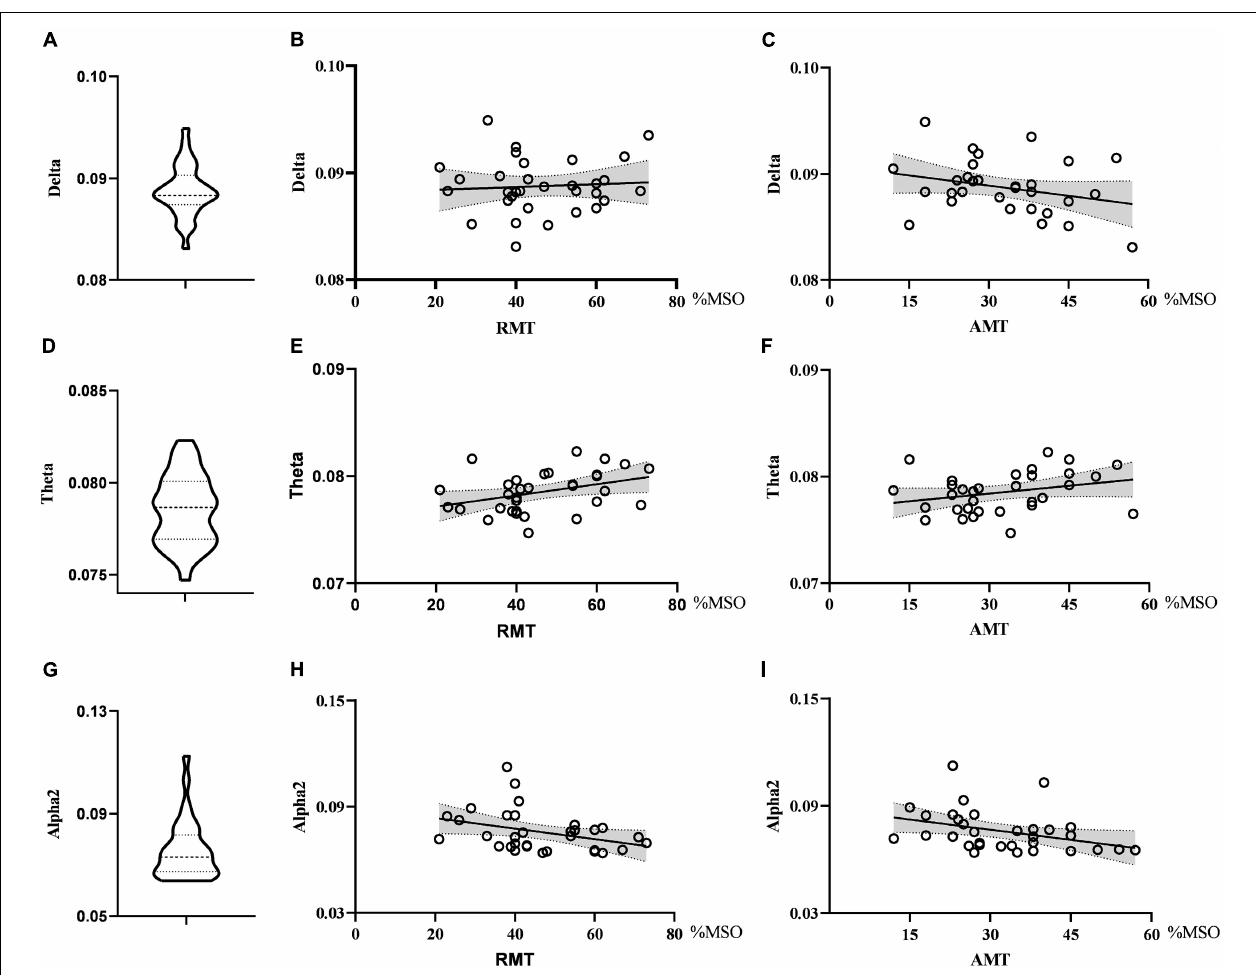
FIGURE 5 | Violin diagrams and scatter diagrams. Violin diagrams showed the distribution of global efficiency in delta, theta, and alpha2 band (A,D,G) . Scatter diagrams showed the correlation between global efficiency and motor threshold (B,C,E,F,H,I) . There was significant positive correlation between global efficiency in theta and RMT. And there were significant negative correlations between global efficiency in alpha2 and RMT as well as